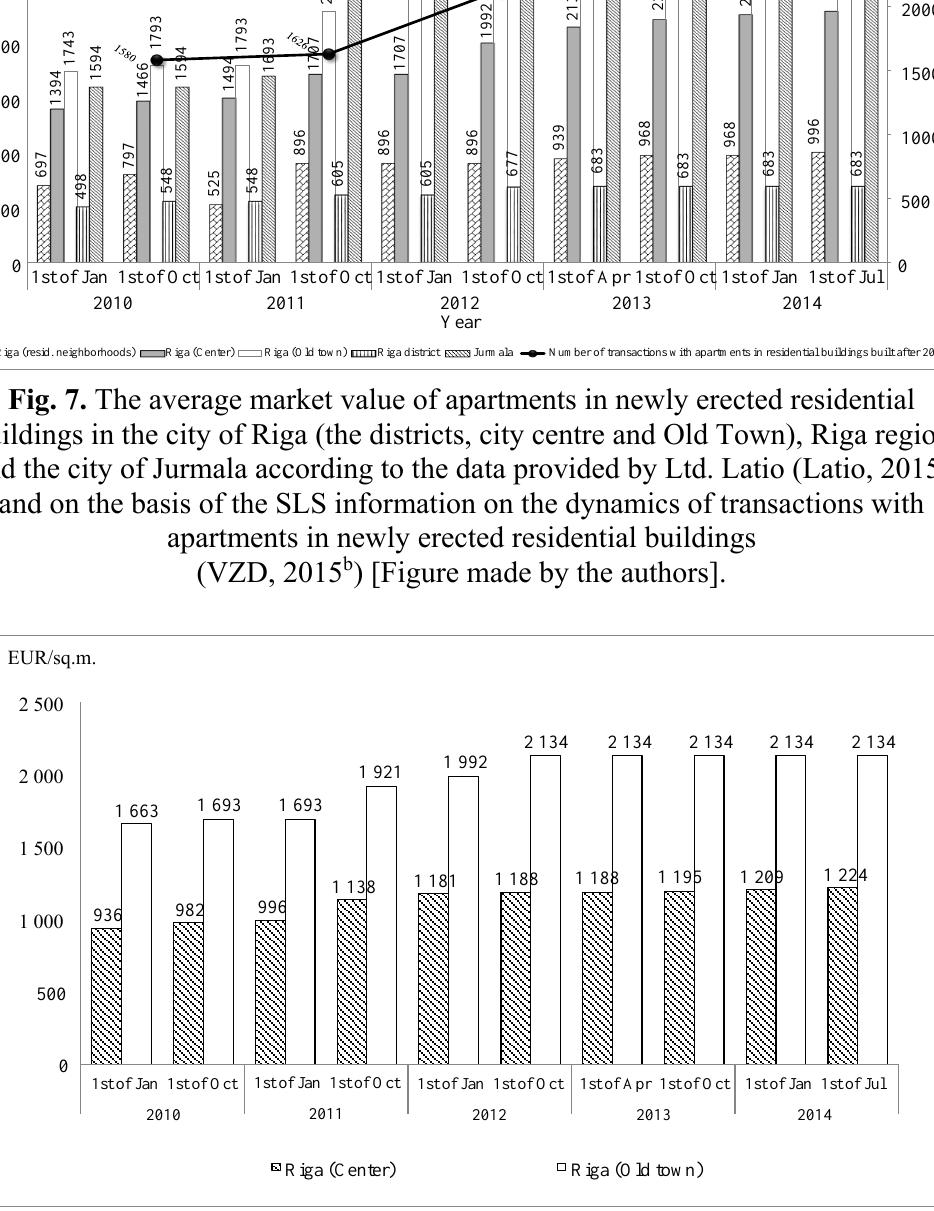
Fig. 8. The average market value of apartments in reconstructed pre-war houses built before 1940 in the centre of Riga and the Old Town according to the data provided by Ltd. Latio (Latio, 2015) [Figure made by the